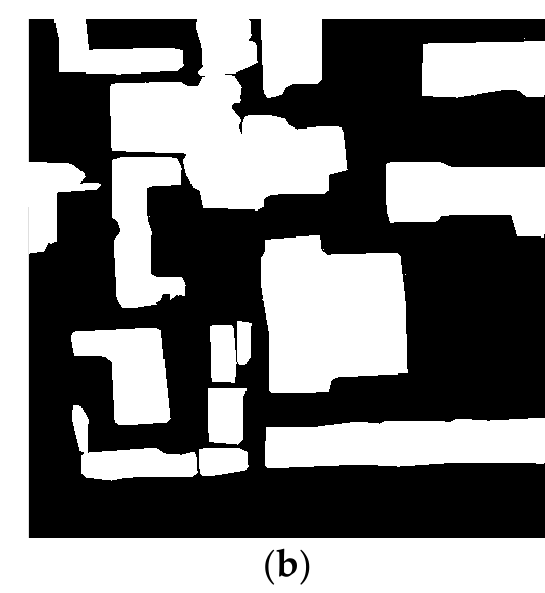
Figure 9. Image and label example selected from the China typical cities building dataset: ( a ) Original image; ( b ) Ground truth. Black and white pixels mark non-building and building, respectively.